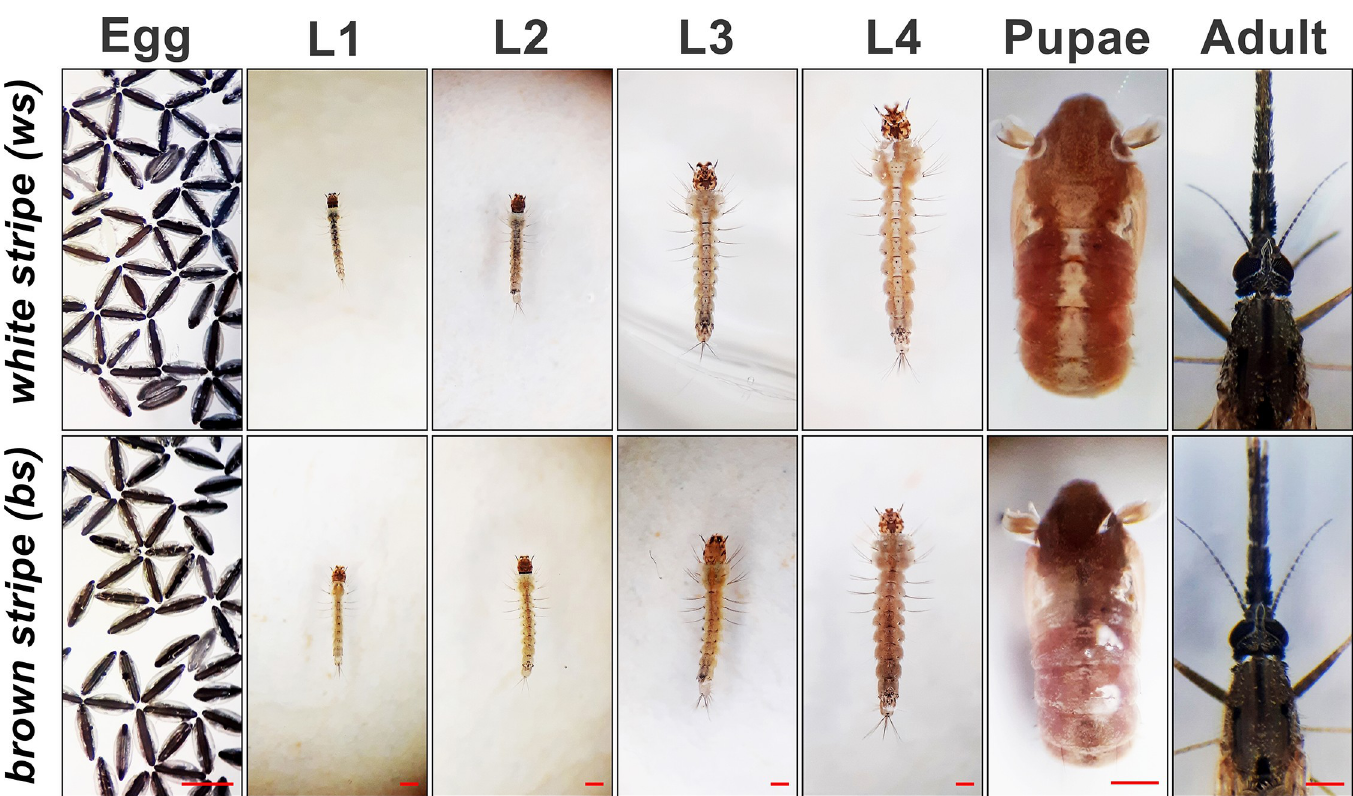
Fig 1. An . albimanus ontogeny of ws and bs striped phenotypes. The phenotypic differences (white or brown stripe along the dorsal thorax and abdomen) are only visible from the 3 rd instar larval stage until the pupa stage. Adult photographs were obtained from female mosquitoes three days post-emergence. Pupae are from the first 12 hours. Scale bar = 500 μ